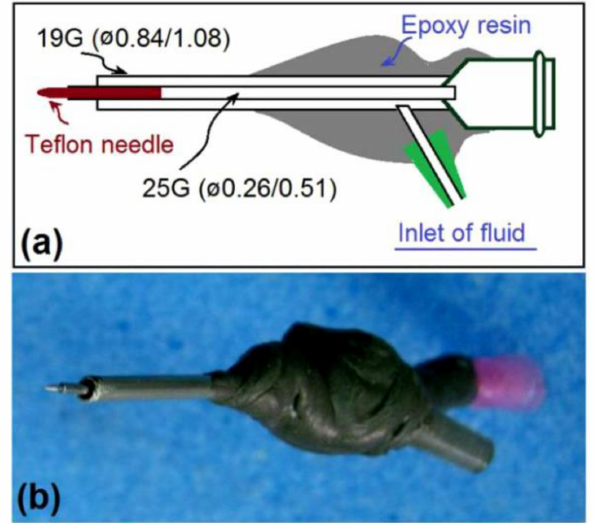
Figure 3. Proposed concentric spinneret with a solid Teflon rod. ( a ) Diagram showing the inner structure of the spinneret. ( b ) Digital photograph of the complete spinneret.